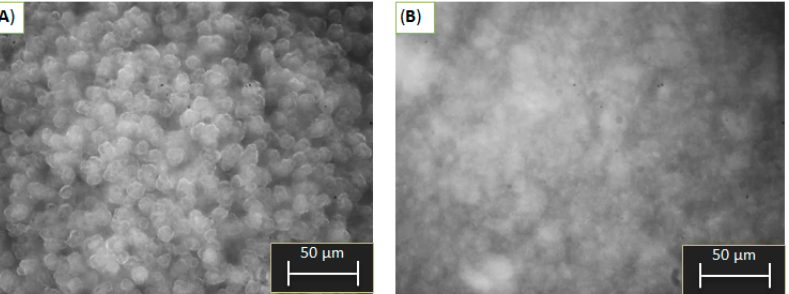
Figure 2. Optical image of suspension particles at the end of precipitation Al-6 ( A ) and Al-9 ( B ).